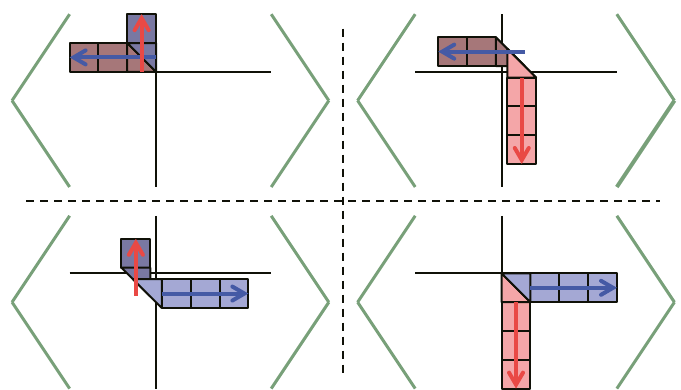
Figure 4 . The four types of correlation functions in the ABJM matrix model where the determinant of the shifted Giambelli relation (2.21) contains only one component H . The upper-left, upper- ( e A j e B ) right, lower-left and lower-right (cid:12)gures denote respectively S 0 = H , S 1 = H , ( (cid:0) 3 j(cid:0) 2) ( (cid:0) 3 j 3) (0 j 2) ; (0 j 1) (cid:15) ; (1 j 2) S (cid:0) 1 = H and S 0 = H . The blue arrow and the red arrow denote respectively (3 j(cid:0) 2) (3 j 3) (3 j 3) ; (cid:15) (2 j 0) ; (0 j 0) the arm length and the leg length in the shifted Frobenius notation, while the blue box and the red box are related to the arm length and the leg length of the two Young diagrams with the light color and the dark color used respectively for (cid:21) and (cid:22) in the composite Young diagram (cid:21)(cid:22) = ( (cid:21); (cid:22) ). Though the expression in (3.14) seems cumbersome, the correlation functions in the ABJM matrix model with only one component of H are simply the hook types in terms of the composite ( e A j e B ) Young diagram.